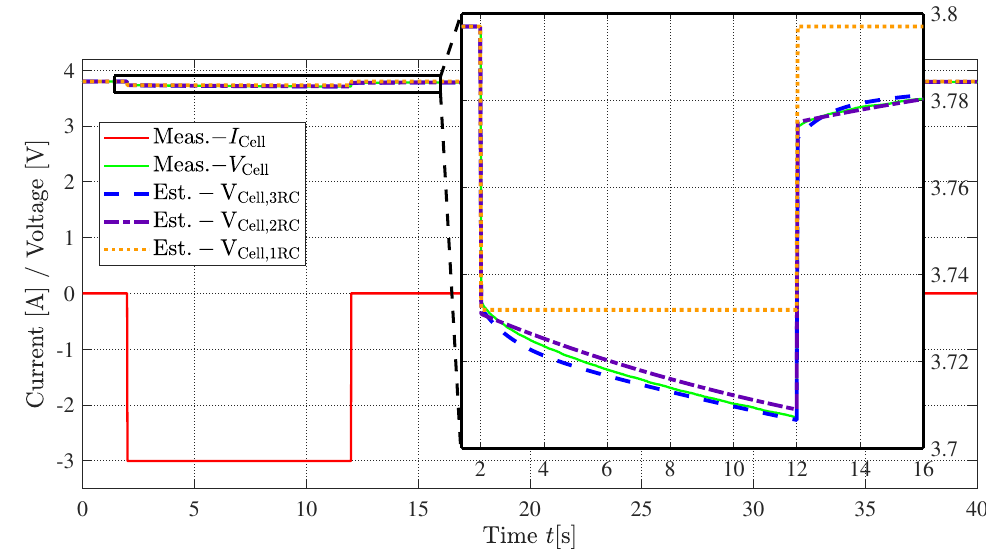
Figure 8. Measured cell voltage behavior for a current step in comparison to simulations for a cylindrical 18650 battery cell from LG Chem of model type HG2 with a nominal capacity of